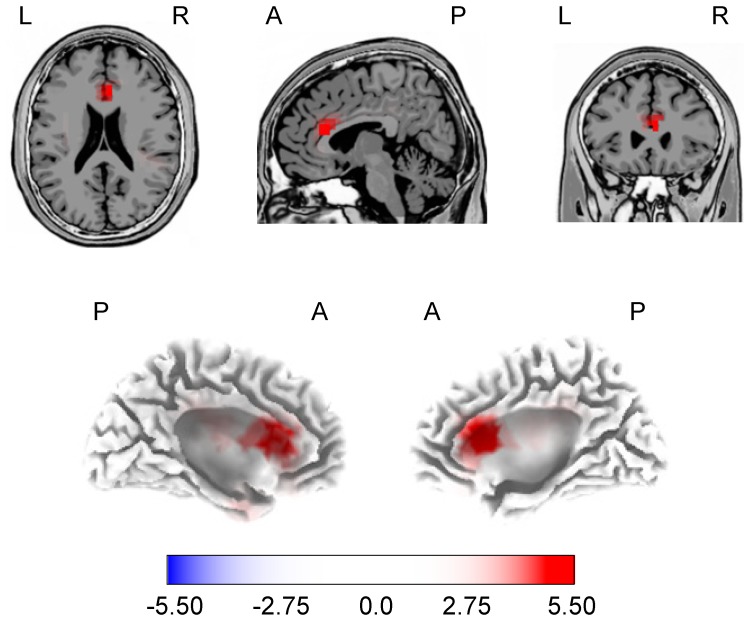
Activation of brain regions as revealed by sLORETA analysis.P3a responses of the physically active and inactive groups were contrasted and tested for significance using the sLORETA-built-in voxelwise randomization test. The statistical cut-off was set to a significance level of p = 0.05. Data from all participants were projected onto a single anatomical image (MNI-template of sLORETA) with transversal, sagital, and coronal slices positioned at Talairach xyz-coordinates of 5, 25, 20 mm, respectively, to focus on maximum activation (upper row) and 3D cortical surface (lower row). A anterior, P posterior, L left, R right.